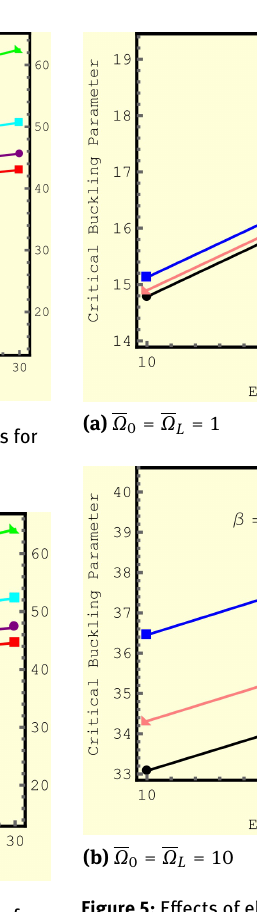
Figure 3: Effects of elastic springs on the critical buckling loads for different small scale parameter with K = 30